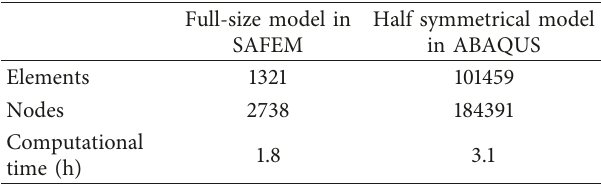
Table 5: Comparison of the elements, nodes, and computational time between SAFEM and ABAQUS in static analysis with linear viscoelastic material property.